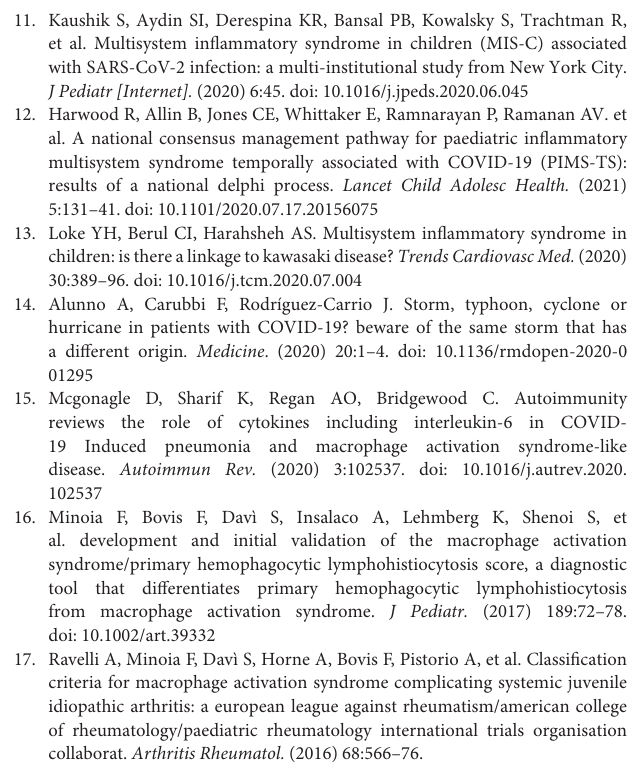
Supplementary Figure 1 | Lung. (A) GROSS image: on sectioning, the cut surface is reddish, firm (red hepatization—RH). No mass or gross thrombi are present. (B) × 4 high-power field (HPF) and (C) × 10 HPF—lung parenchyma with edema-e, hyaline membranes (arrow), and hemorrhage coating the alveoli ( ∗ ). Supplementary Figure 2 | (A) GROSS image: The external surface is smooth brown-yellowish, with lobulations. On sectioning, the cut surface is green-yellowish, without masses or other injuries. (B,C) × 10 hpf—massive hepatic necrosis (Ne) ( ∼ 90%), hepatocyte ballooning with little viable residual parenchyma in zones 2 and 3 ( ∗ ), observing hepatocytes with multinucleated giant cell transformation (GC), and marked cholangiolar proliferation (cp); (D) × 40 hpf—hepatocytes with multinucleated giant cell transformation